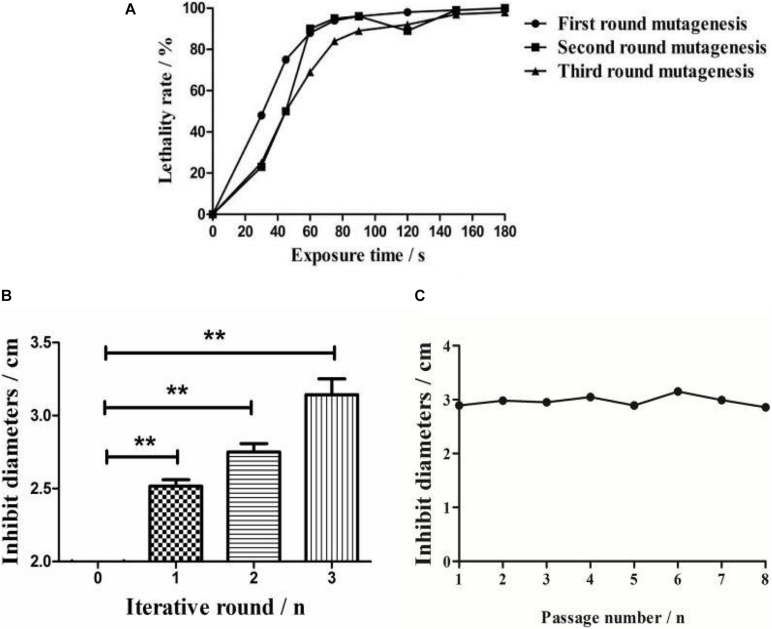
Comparative analysis of ARTP mutagenesis process. (A) The lethality rate of the wild-type strain under different ARTP actuation durations. (B) Bacterial inhibition diameters of the wild-type strain and the active mutant strains after three iterations of ARTP mutagenesis. **P < 0.01. (C) Generational fermentation of the mutant strains.